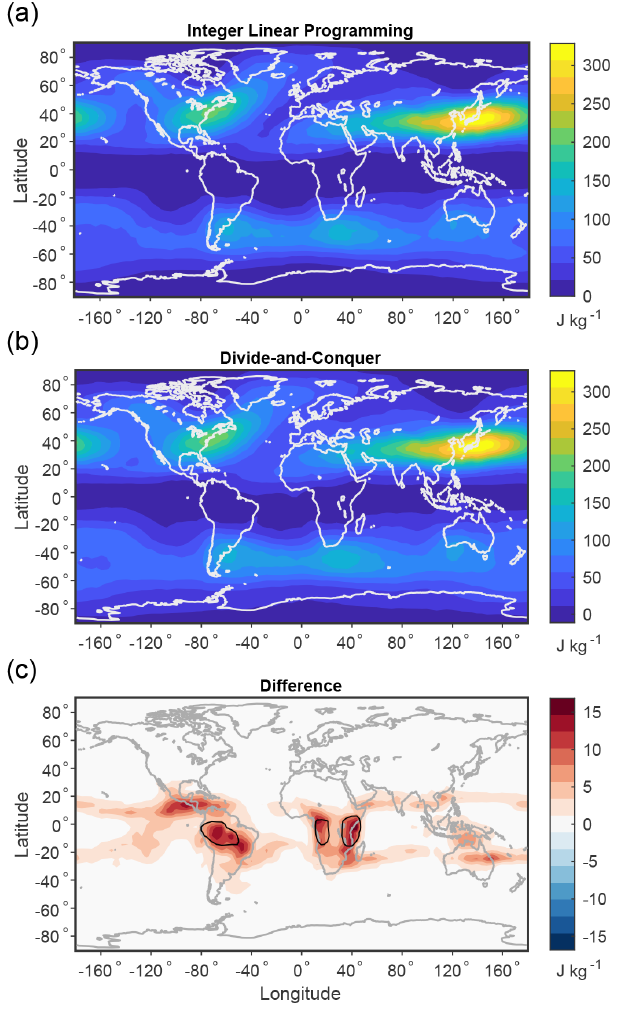
Figure B6. Sensitivity to calculation method for the maximum po- tential ascent in local MAPE based on the DJF climatological mean over 1979–2018. Shown is maximum potential ascent calculated using (a) the exact integer linear programming approach, (b) the approximate divide-and-conquer algorithm, and (c) the difference reported as integer linear programming minus divide and